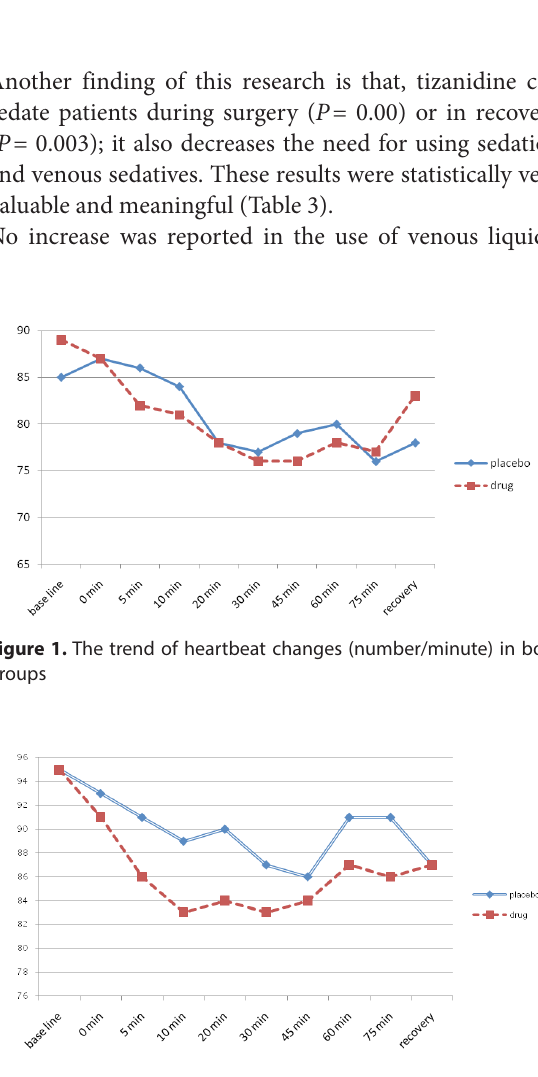
Figure 2. The trend of average blood pressure changes (mm Hg) in both